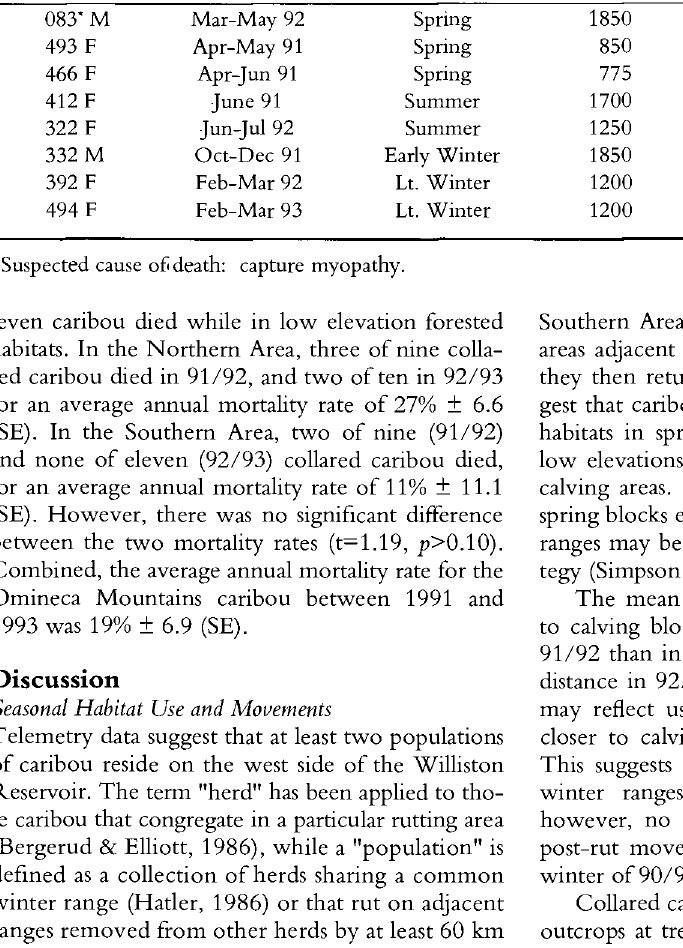
Table 5. Season, elevation and habitat of collared caribou mortalities during 91/92 and 92/93. M- male, F - female.